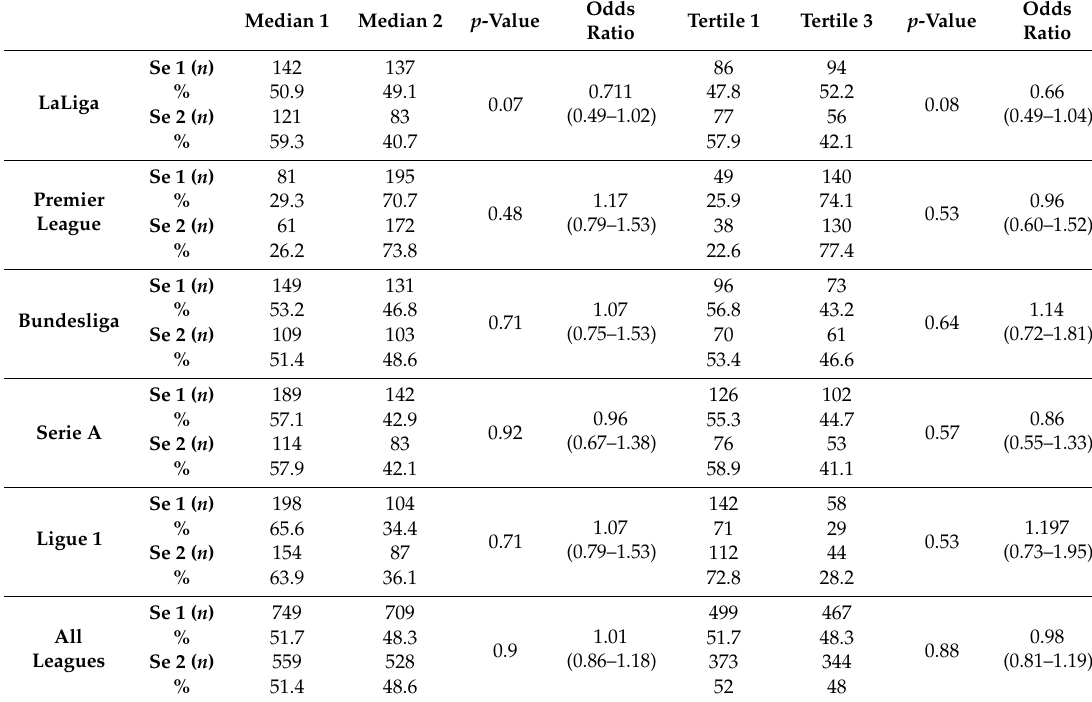
Table 5. Median (median 1 = 0.1–3 M € ; median 2 ≥ 3.1 M € ) and tertile (tertile 1 = 0.1–1.5 M €